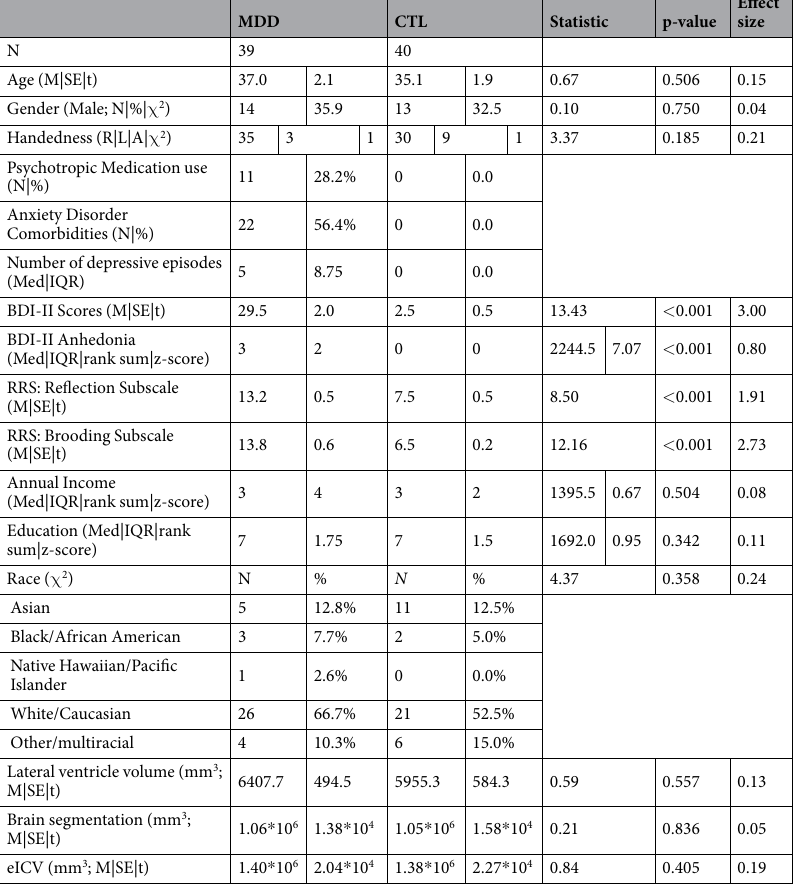
on this measure to these participants and conducted a median split of the MDD group on the number of previous episodes experienced. This procedure yielded a subgroup of MDD participants who had experienced 5 or fewer depressive episodes ( N = 22) and a subgroup who had experienced 6 or more episodes ( N = 17). These MDD subgroups did not differ with respect to age ( t (37) = 1.25, p = 0.219, Cohen’s d = 0.40). We conducted GLMs to compare R1 in these two subgroups, and further examined significant between-group differences by comparing each subgroup with the CTL group. The two MDD subgroups did not differ in R1 at the whole-brain level, in the NAcc, insula, sgACC, or in the visual network control regions. The MDD subgroup with more depressive episodes exhibited lower R1 in both the LPFC and mPFC than did the MDD subgroup with fewer depressive episodes (LPFC: t (37) = 2.11, p = 0.042, Cohen’s d = 0.68; mPFC: t (37) = 2.08, p = 0.045, Cohen’s d = 0.67). Subsequent GLMs conducted with whole-brain covariates indicated that the more depressive episodes MDD subgroup also had lower LPFC R1 than did the CTL group ( F (1) = 4.24, p = 0.044, partial η 2 = 0.07), while CTL group R1 did not differ significantly from the fewer depressive episodes MDD subgroup ( F (1) = 0.23, p = 0.633, partial η 2 = 0.00). Neither the MDD sub- group with more depressive episodes nor the MDD subgroup with fewer depressive episodes differed significantly from the CTL group in R1 in mPFC group (more episodes subgroup: F (1) = 1.20, p = 0.279, partial η 2 = 0.02; fewer episodes subgroup: F (1) = 3.37, p = 0.072, partial η 2 = 0.05). See Table 3 for all results comparing more and less episodes MDD subgroups.